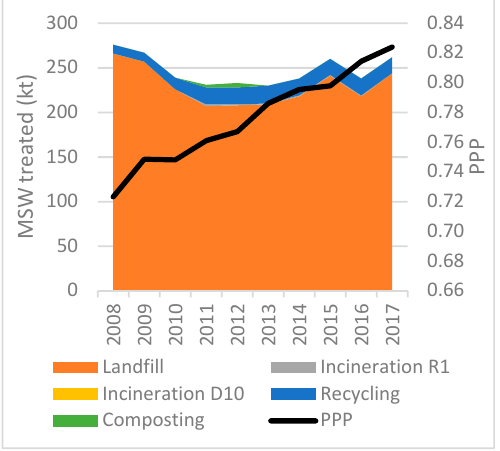
Figure 36. Waste treatment methods and PPP in Malta 2008–2017 (EUROSTAT 2019b, 2019c).